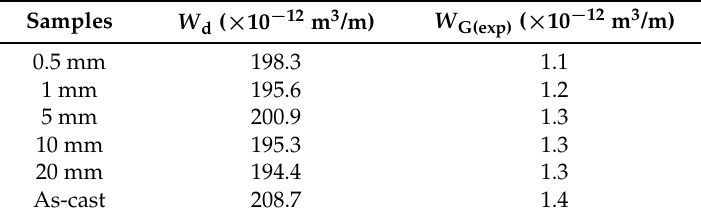
Table 1. Comparison between the calculated theoretical delamination wear rate ( W d ) and the actual global wear rate ( W G(exp)